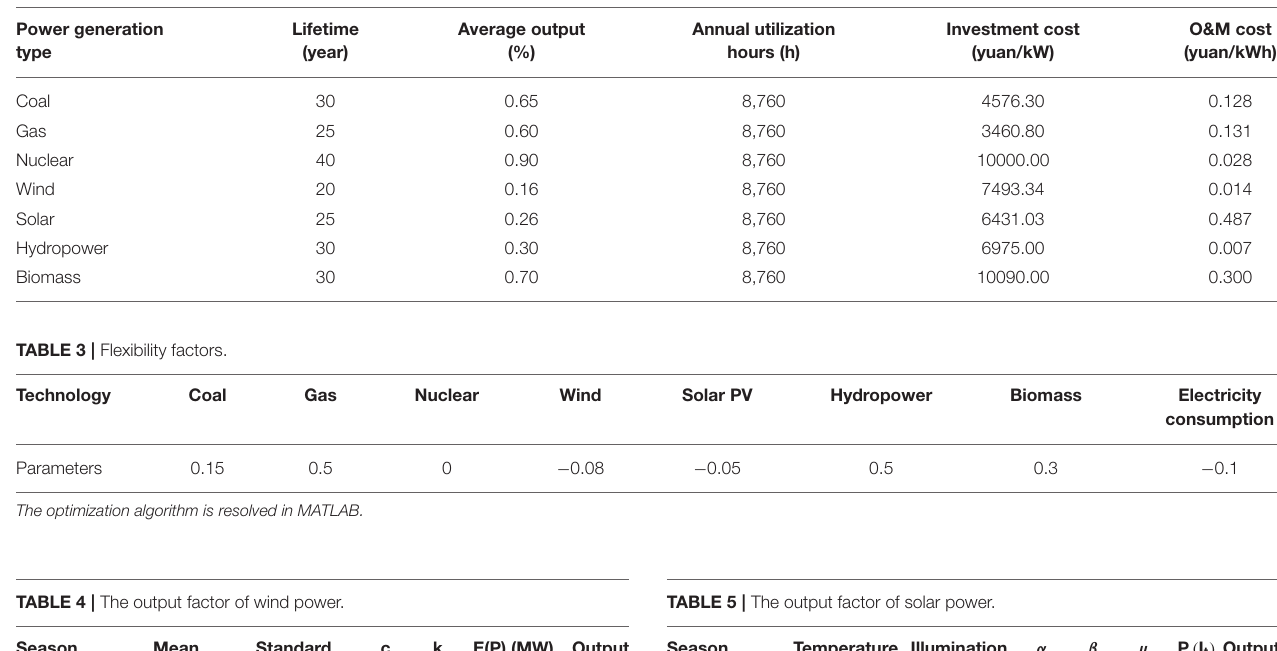
TABLE 2 | Technical and economic parameters of power generation technology in the base year.